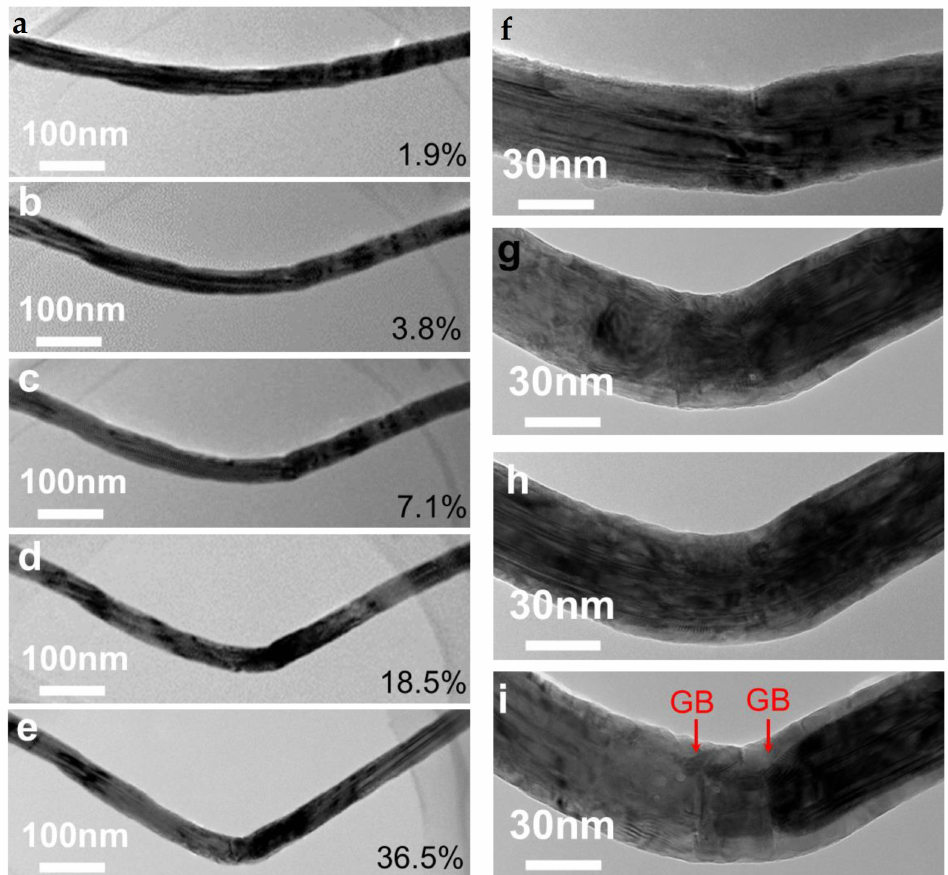
Figure 3. ( a – e ) Low-magnification bright field TEM images showing the evolution of the nanoscale structure of a Ni NW with growth twins under the bending strain of 1.9–36.5%. ( f – i ) Enlarged TEM images show two GBs generated in severely bent Ni NWs.